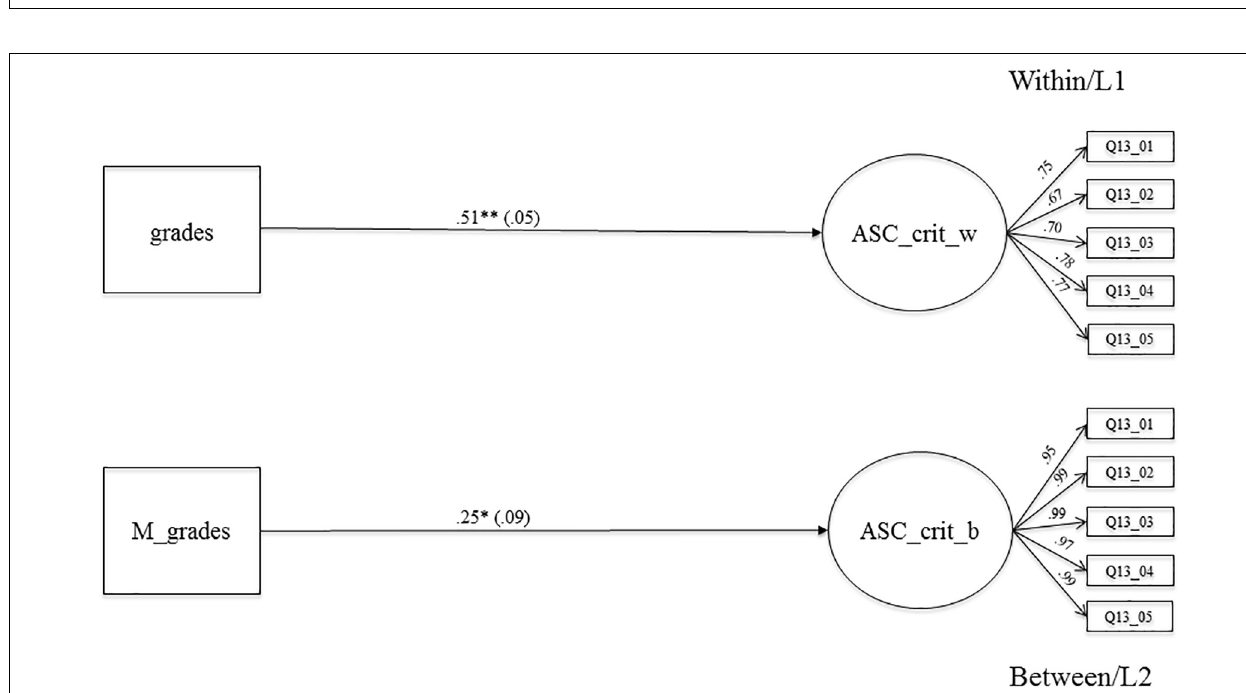
FIGURE 2 | The relationship between averaged grades in Math, German, English as a foreign language. Biology and absolute academic self-concept on the within and between level. Level 1, student level; Level 2, classroom level; regression coefficients were standardized by group-mean-centering; grades, averaged grades at the end of the school year 7 (Math, German, English as a foreign language, Biology); ASC_abs_w, absolute academic self-concept on LI (within); M_grades, aggregated mean-grades on L2; ASC_abs_b, absolute academic self-concept on L2 (between); bold pathways are significant at ∗ p < 0.05, ∗∗ p < 0.001; dotted pathways are not significant.